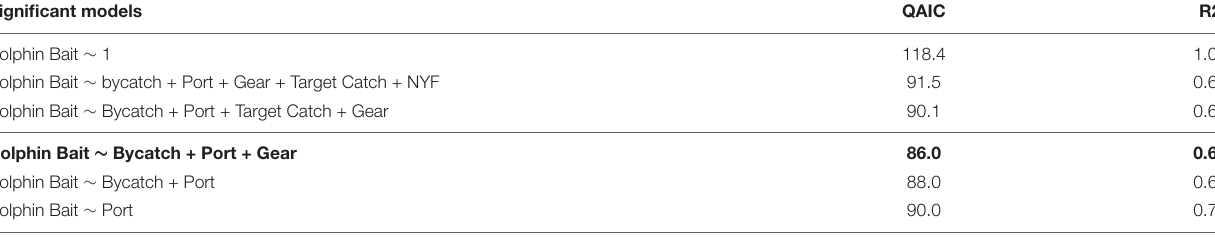
TABLE 3 | Summary results of GLM analysis. Significant models